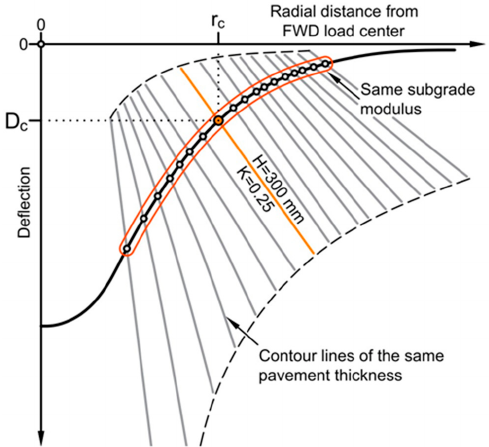
Figure 12. Contour lines of inertial points of the same pavement thickness.